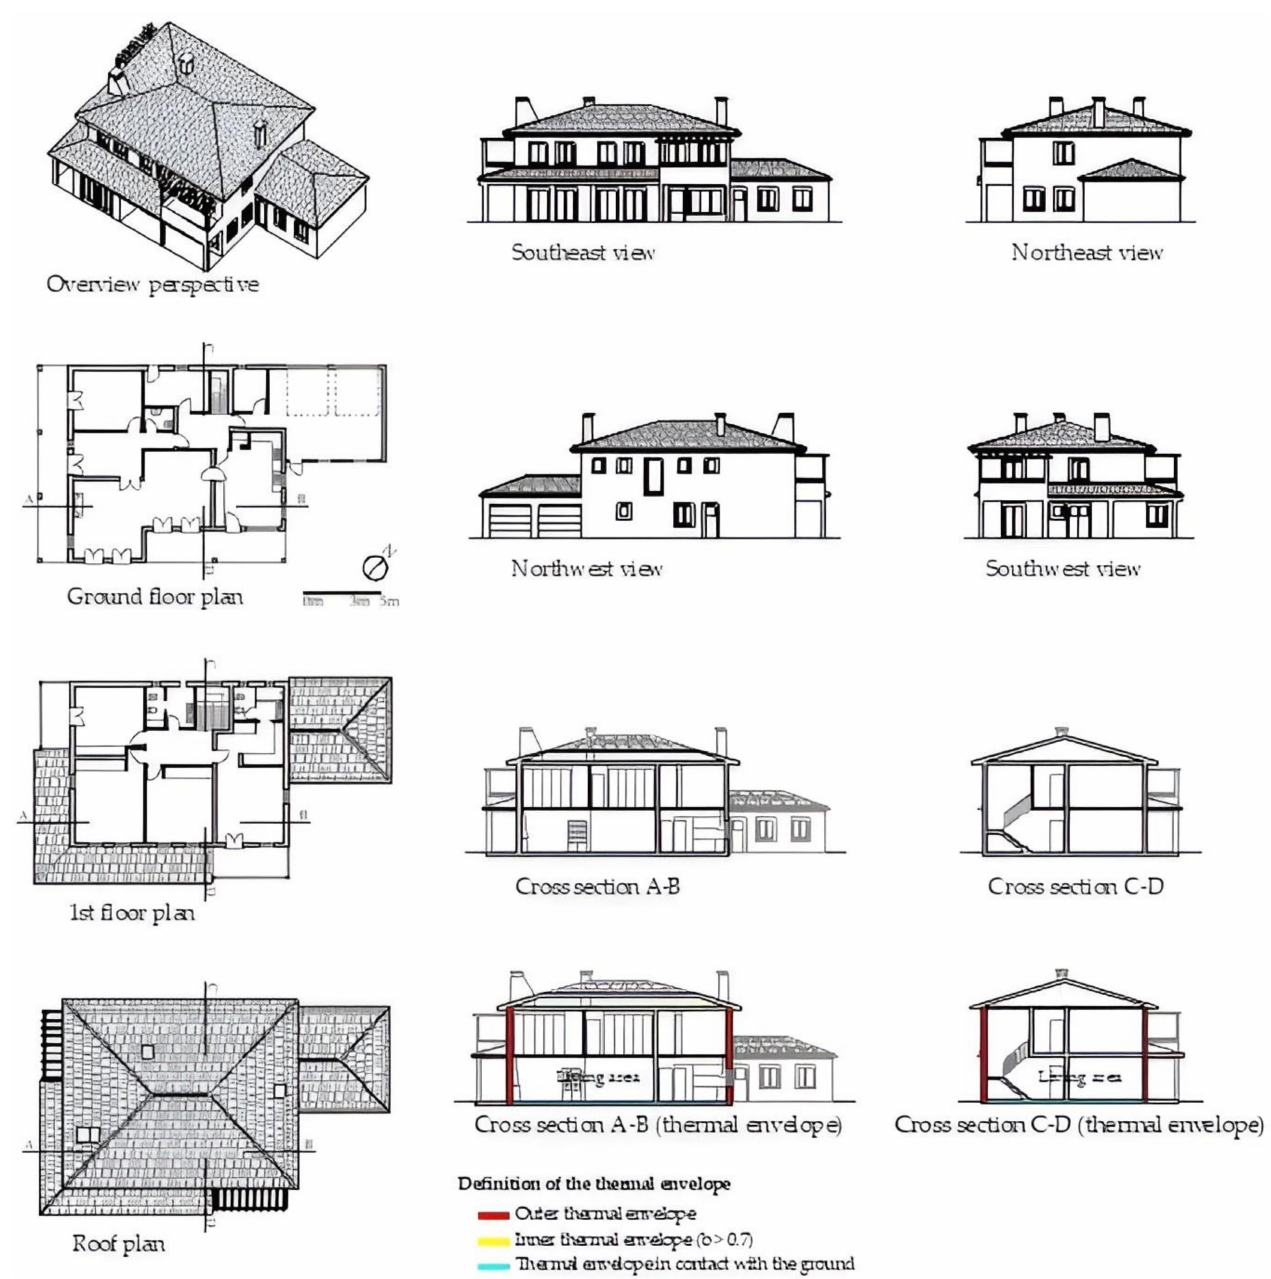
Figure 2. Case Study